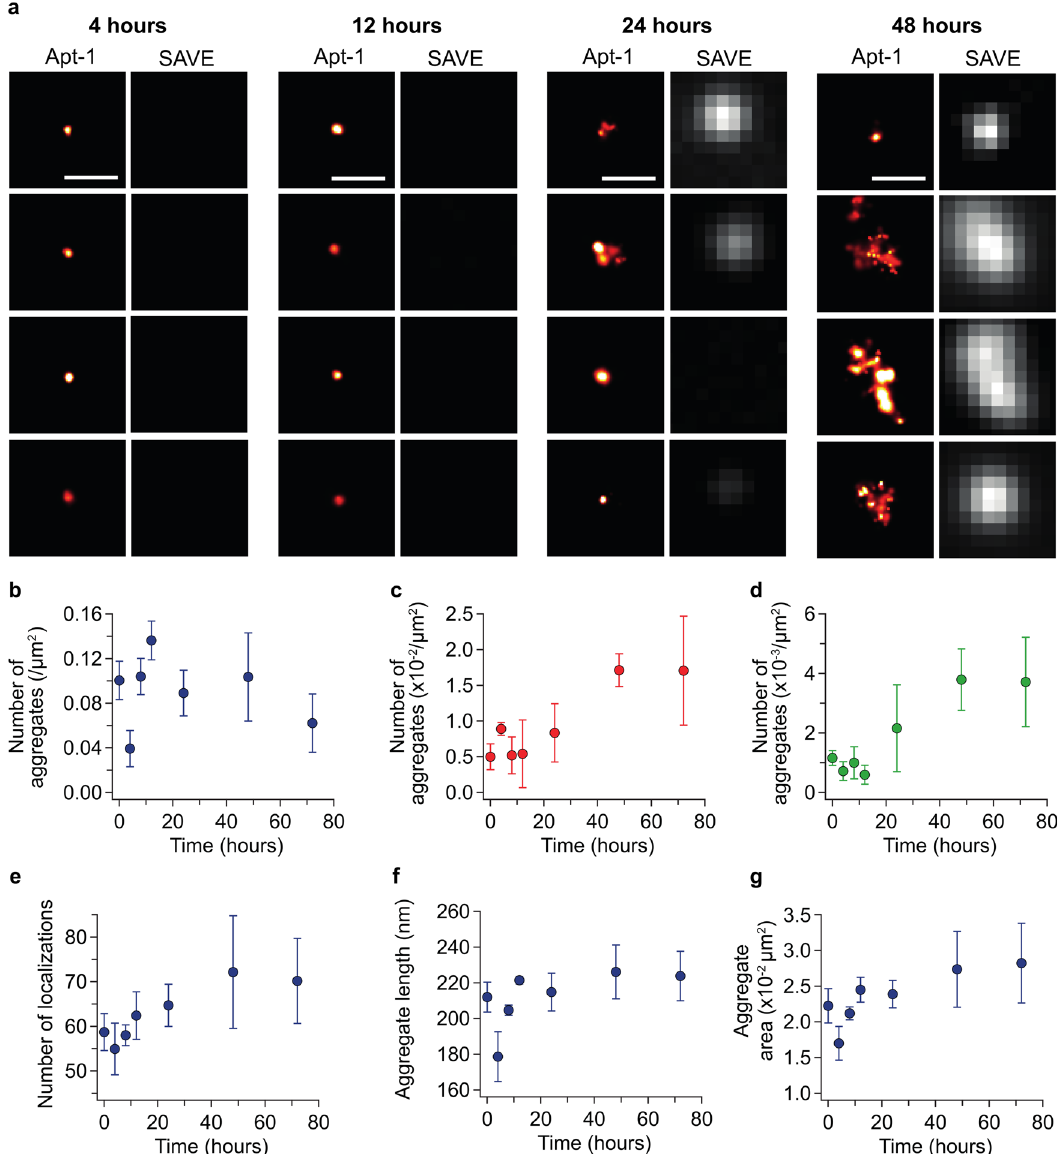
Fig. 5 Following the aggregation of RRM1-2 using Apt-1 and SAVE imaging. a Representative Apt-1 SR images (left, red hot) and diffraction-limited SAVE images (right, gray) of RRM1-2 species over a 72 h aggregation assay, scale bar: 500 nm. b After an initial decrease in the number of aggregates detected using Apt1 from 0 to 4 h, there is a subsequent increase in their number until 48 h, after which there is a slight decrease as the aggregates get larger in size ( f and g ). c There is an overall increase in the number of ThT-active aggregates detected using SAVE imaging over 72 h. Approximately 10x fewer aggregates are detected using SAVE imaging compared with SR imaging using Apt1. d The number of coincident aggregates, de fi ned as having localizations in the SR image and ThT fl uorescence in the SAVE image, increases over time. At 72 h, only 6% of the aggregates detected using Apt1 are ThT-active. e The mean number of localizations per cluster increases over 72 h, as does the mean length ( f ) and area ( g ) of each aggregate analyzed using SR microscopy. Data shown are mean ± SD of three independent aggregation reactions. Source data are provided as a Source data fi le 64